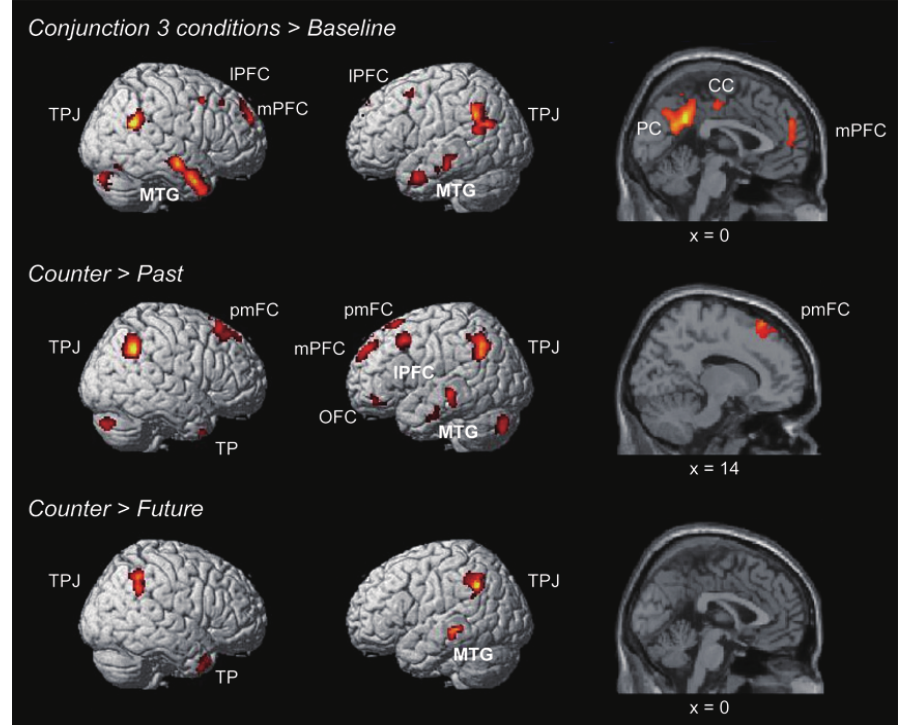
Fig. 1. Whole brain analysis with threshold at p < 0.001 and > 31 voxels (see